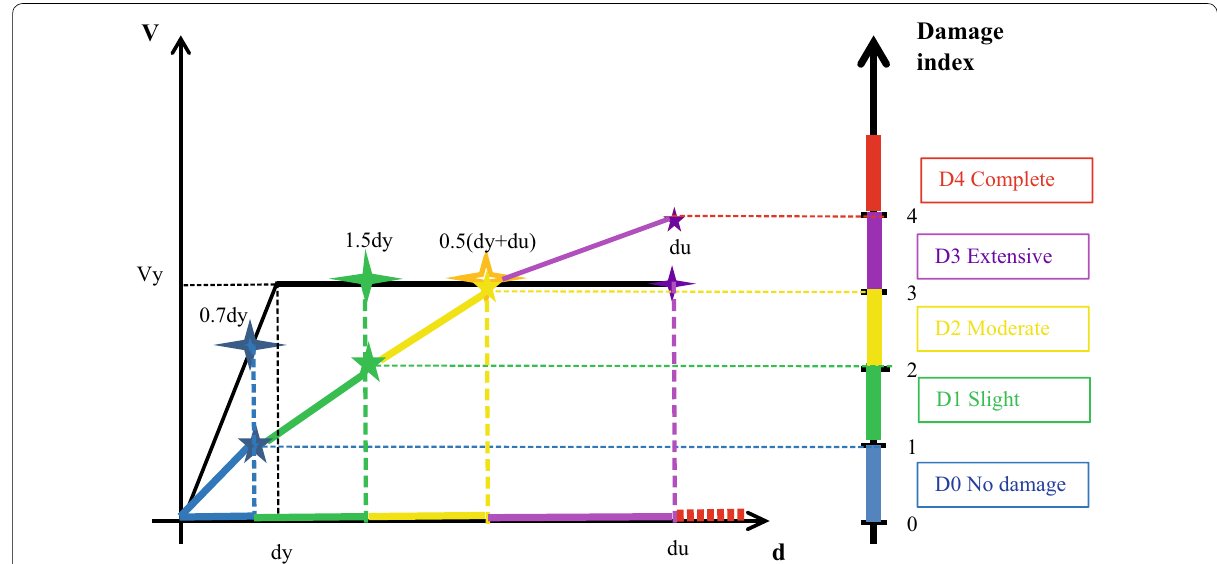
Fig. 2 Definition of the damage index based on the damage state and displacements thresholds of Lagomarsino and Giovinazzi (2006). The black line is the capacity curve; the multi‑colored piecewise linear line corresponds to the new defined damage index. d y is the yield displacement (m) and d u is the ultimate displacement (m). See text for further